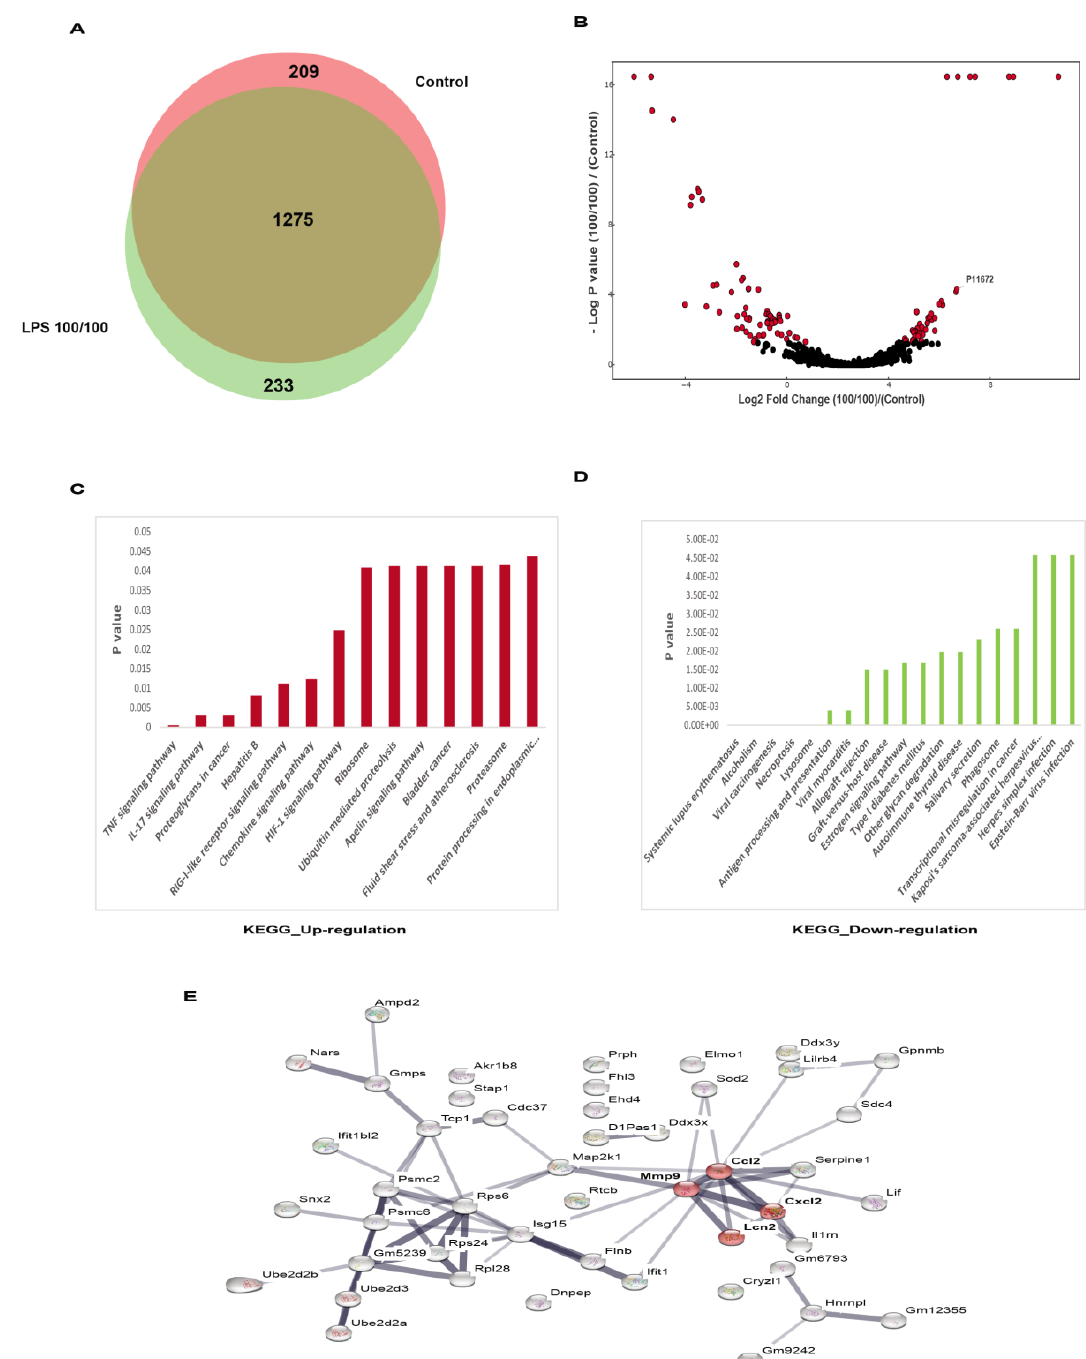
Figure 2. The volcano plot analysis of proteomic from supernatant of RAW264.7 cells after sequential lipopolysaccharide (LPS) stimulation (LPS tolerance; LPS / LPS) compared with control (N / N) (see method) demonstrated down- and up-regulated proteins ( A ) and the Venn diagram indicated the di ff erent number of proteins from LPS tolerance (LPS / LPS) group versus the control ( B ). Additionally, pathway analysis clusters (DAVID) of up- and down-regulated proteins ( C , D ) and the enriched pathway of the proteins in LPS / LPS compared with the control ( E ) were